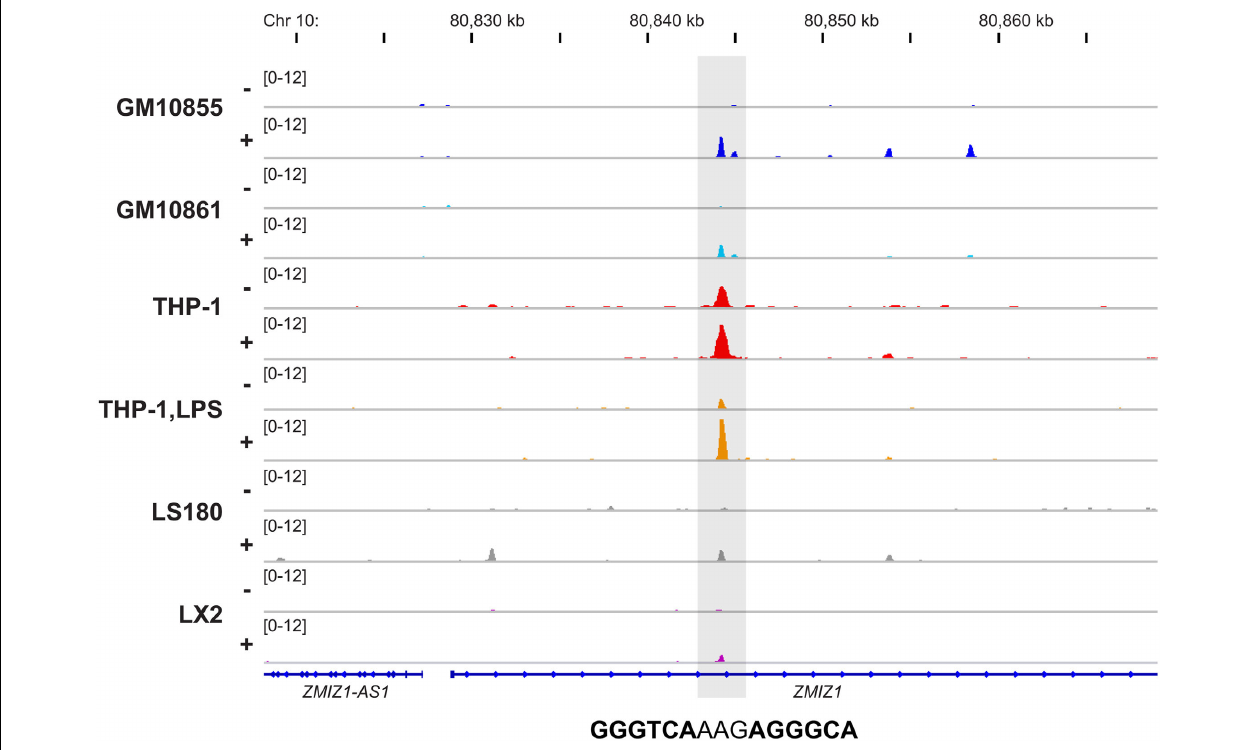
blue), monocyte-like cells (red), macrophage-like cells (orange), colon cells (gray) and liver cells (violet). The cells were either unstimulated ( − ) or treated with VDR ligand ( + ). The gene structures are shown in blue and the sequence of the DR3-type element below the summit of the VDR peak is